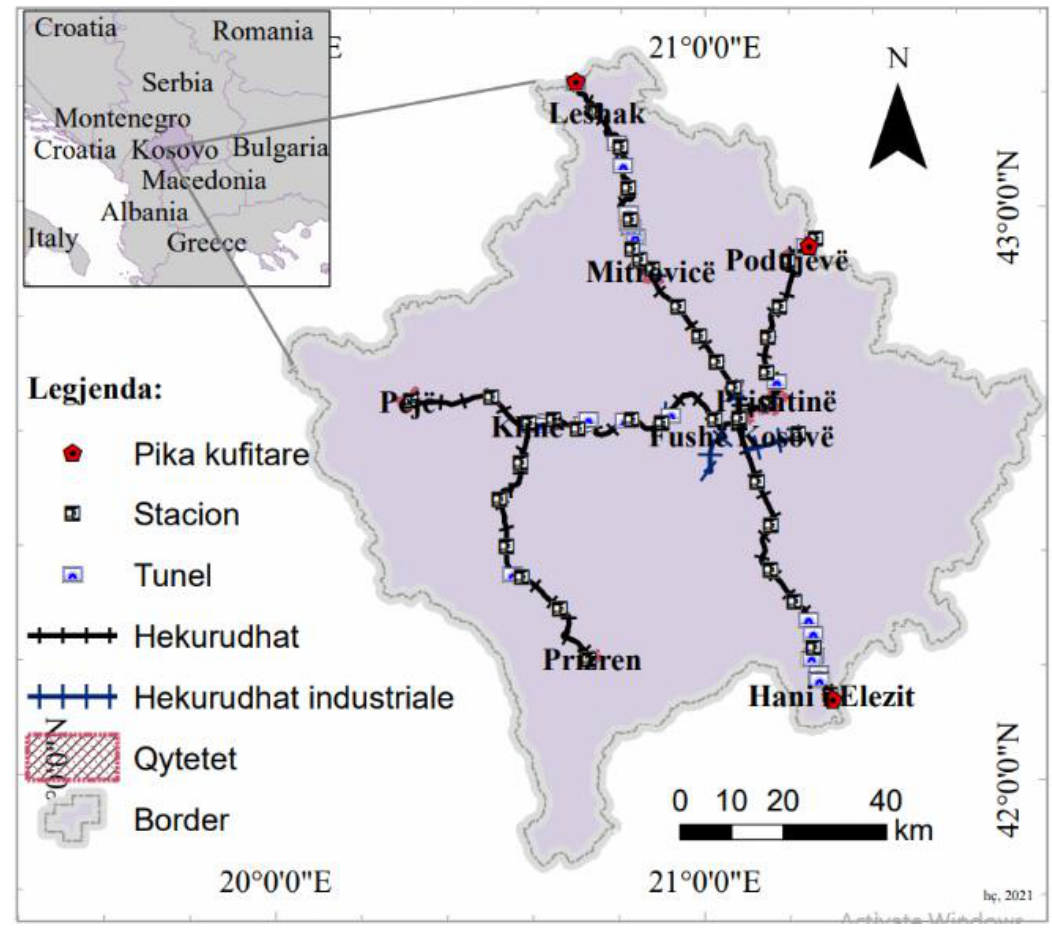
Figure 7. Map of study